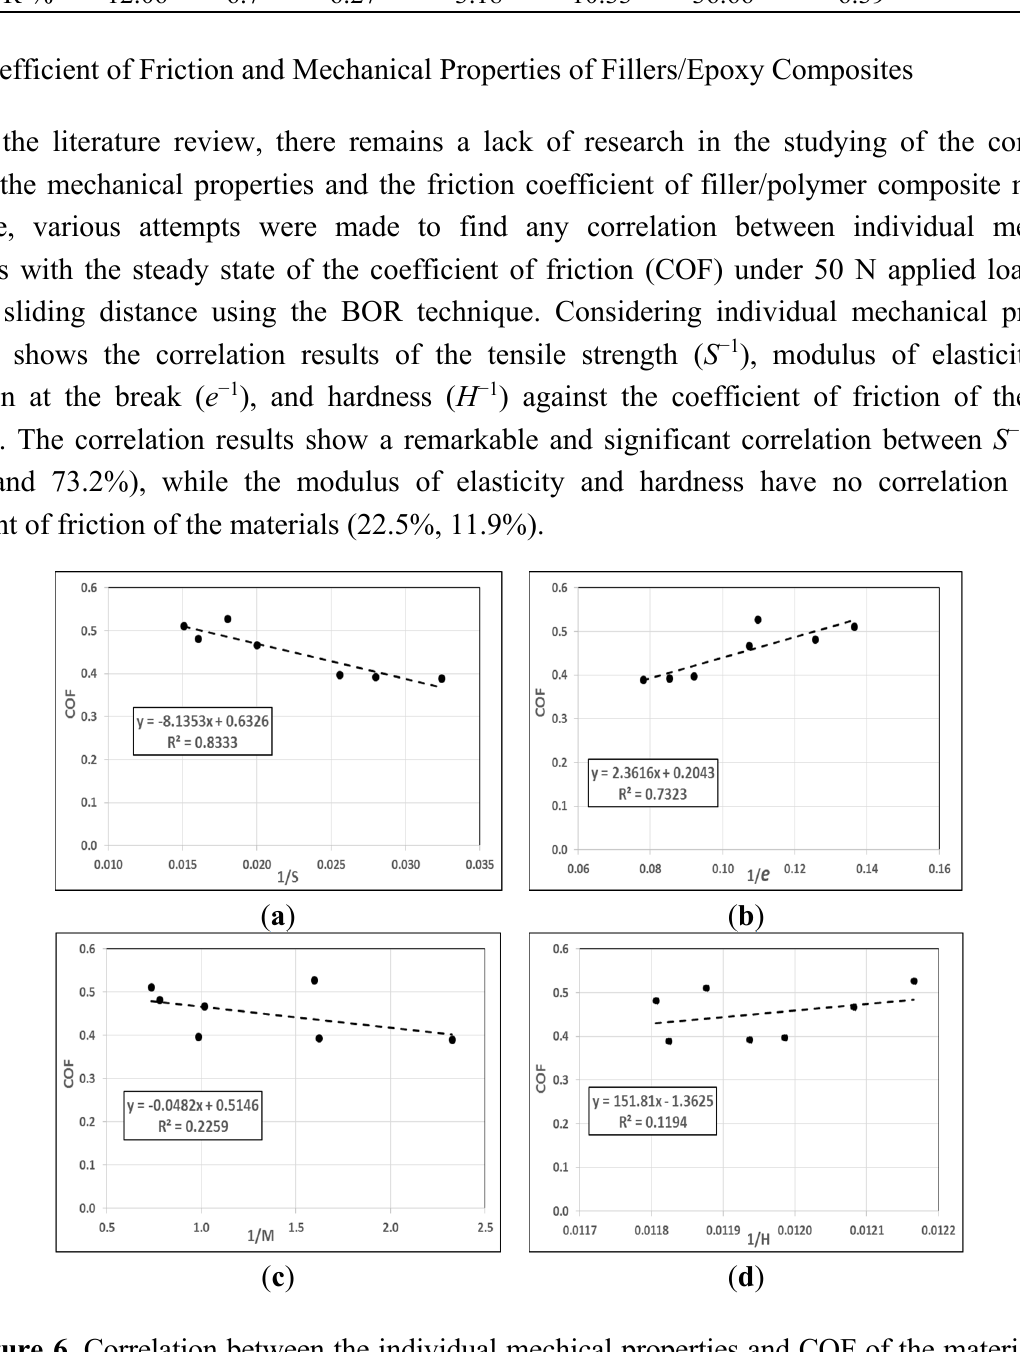
Figure 6. Correlation between the individual mechical properties and COF of the materials. ( a ) Tensile strength; ( b ) Elongation at the break; ( c ) Modulus of elasticity; ( d )